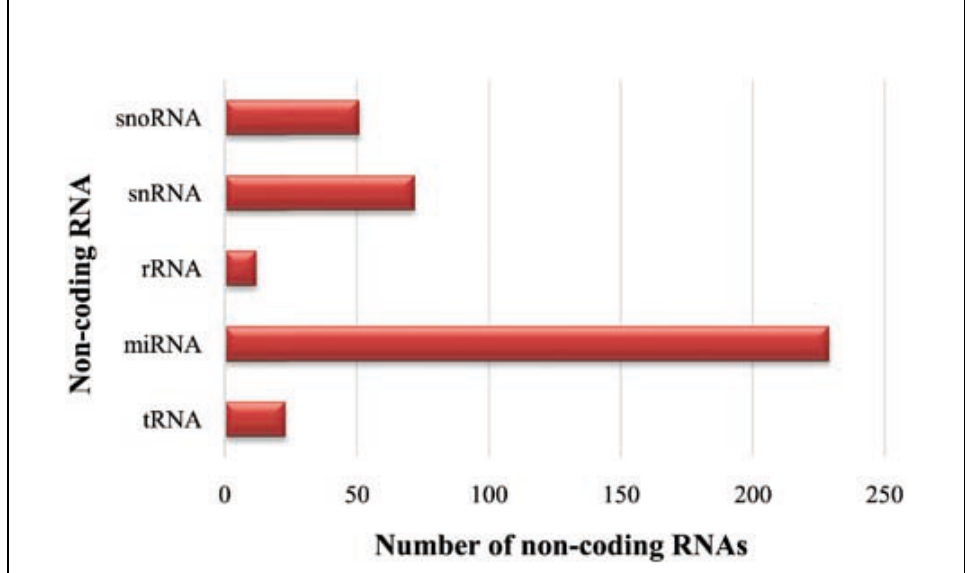
Fig. 2 . Diverse short non-coding RNAs mined across all the samples of milk somatic cells of